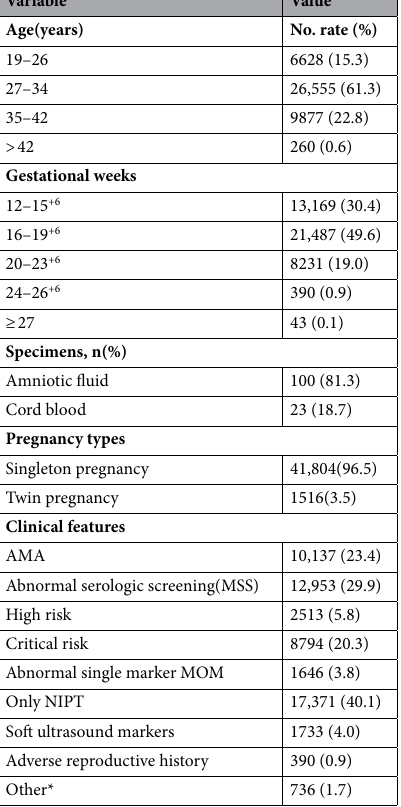
Table 1. Clinical characteristic of pregnant women undergoing NIPT-Plus. AMA advanced maternal age, NIPT noninvasive prenatal testing, n number, MoM multiple of the median, MSS maternal serological screening. *Pregnant women with contraindications for invasive diagnostic